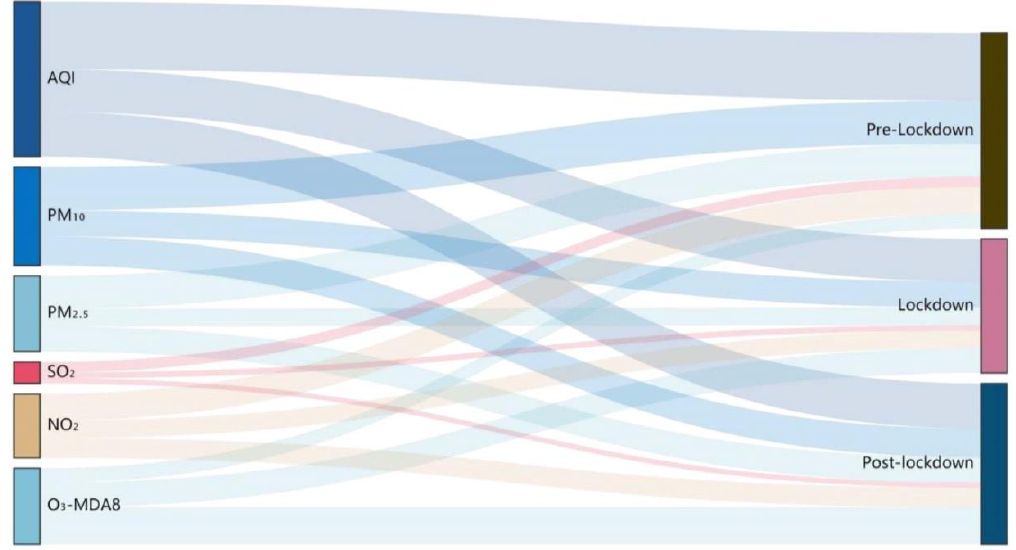
Figure 9. Concentration variations of air quality index (AQI) and five basic pollutants during the preset period.